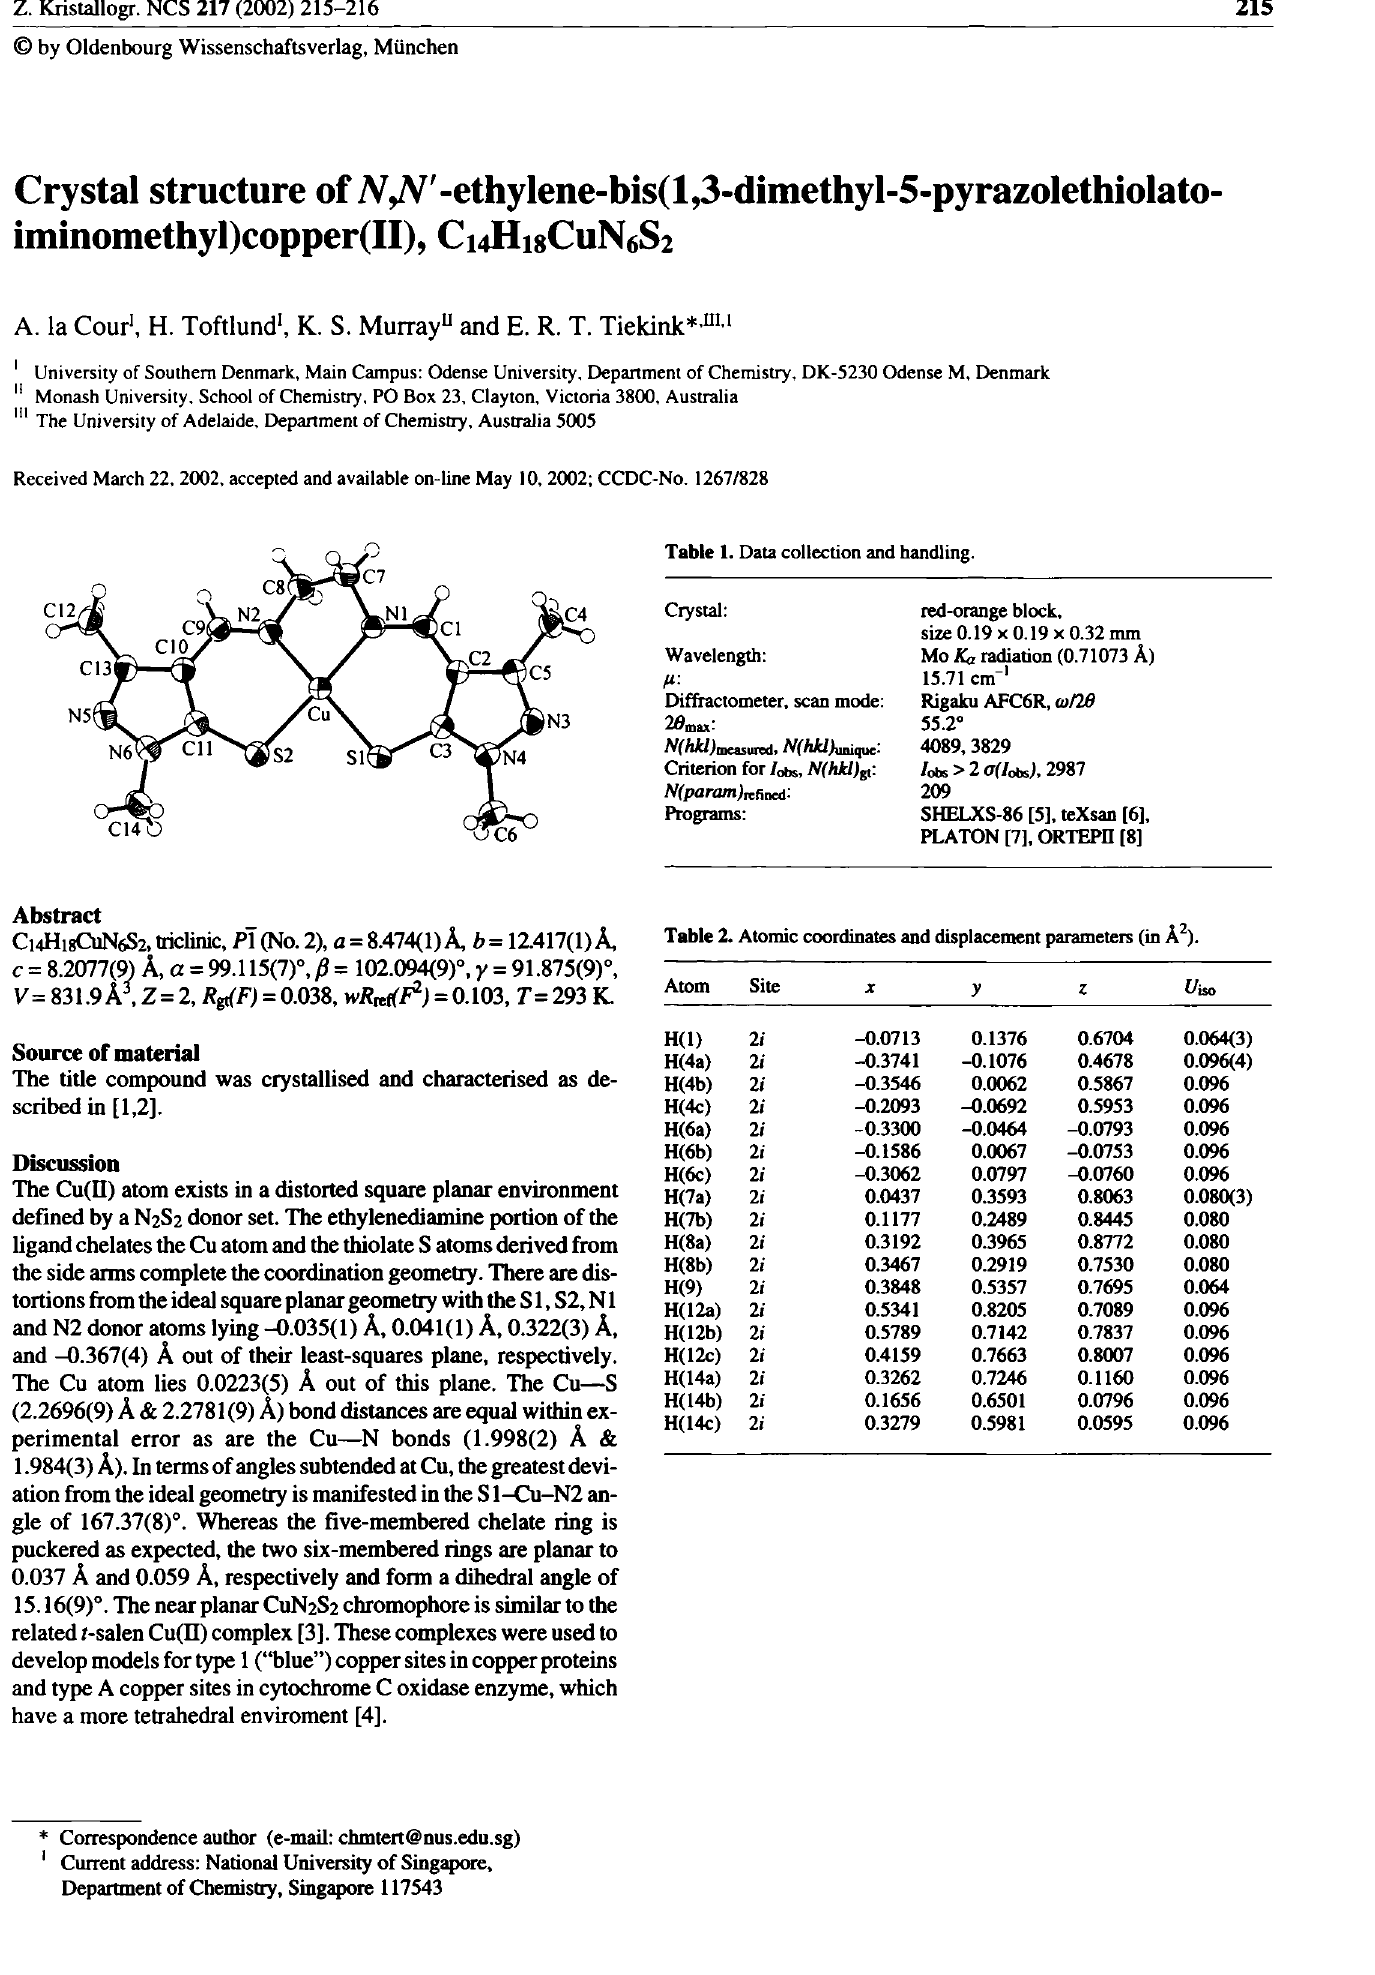
Table 1. Data collection and handling.